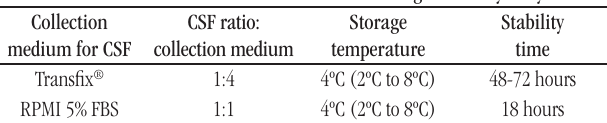
taBLE 2 − Conditions for CSF collection and storage for analysis by FC (3) Collection medium for